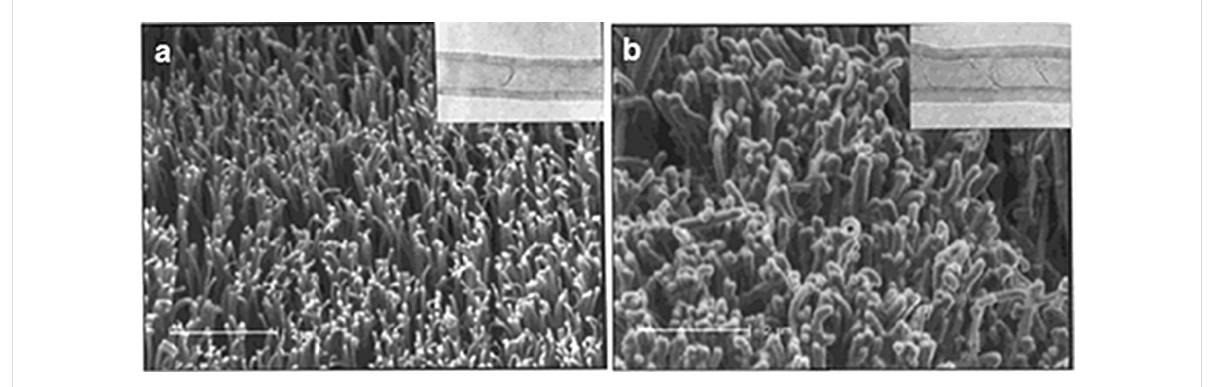
Figure 15: SEM micrographs of the aligned carbon nanotubes (a) before and (b) after plasma polymerization of acetaldehyde. The insets show TEM images of an individual nanotube (a) before and (b) after being coated with a layer of the acetaldehyde-plasma-polymer (optimized conditions for the polymerization of acetaldehyde: 200 kHz, 20 W and a monomer pressure of 0.3 Torr for 5 min). Adapted with permission from [130]. Copyright 2001 American Chemical Society.